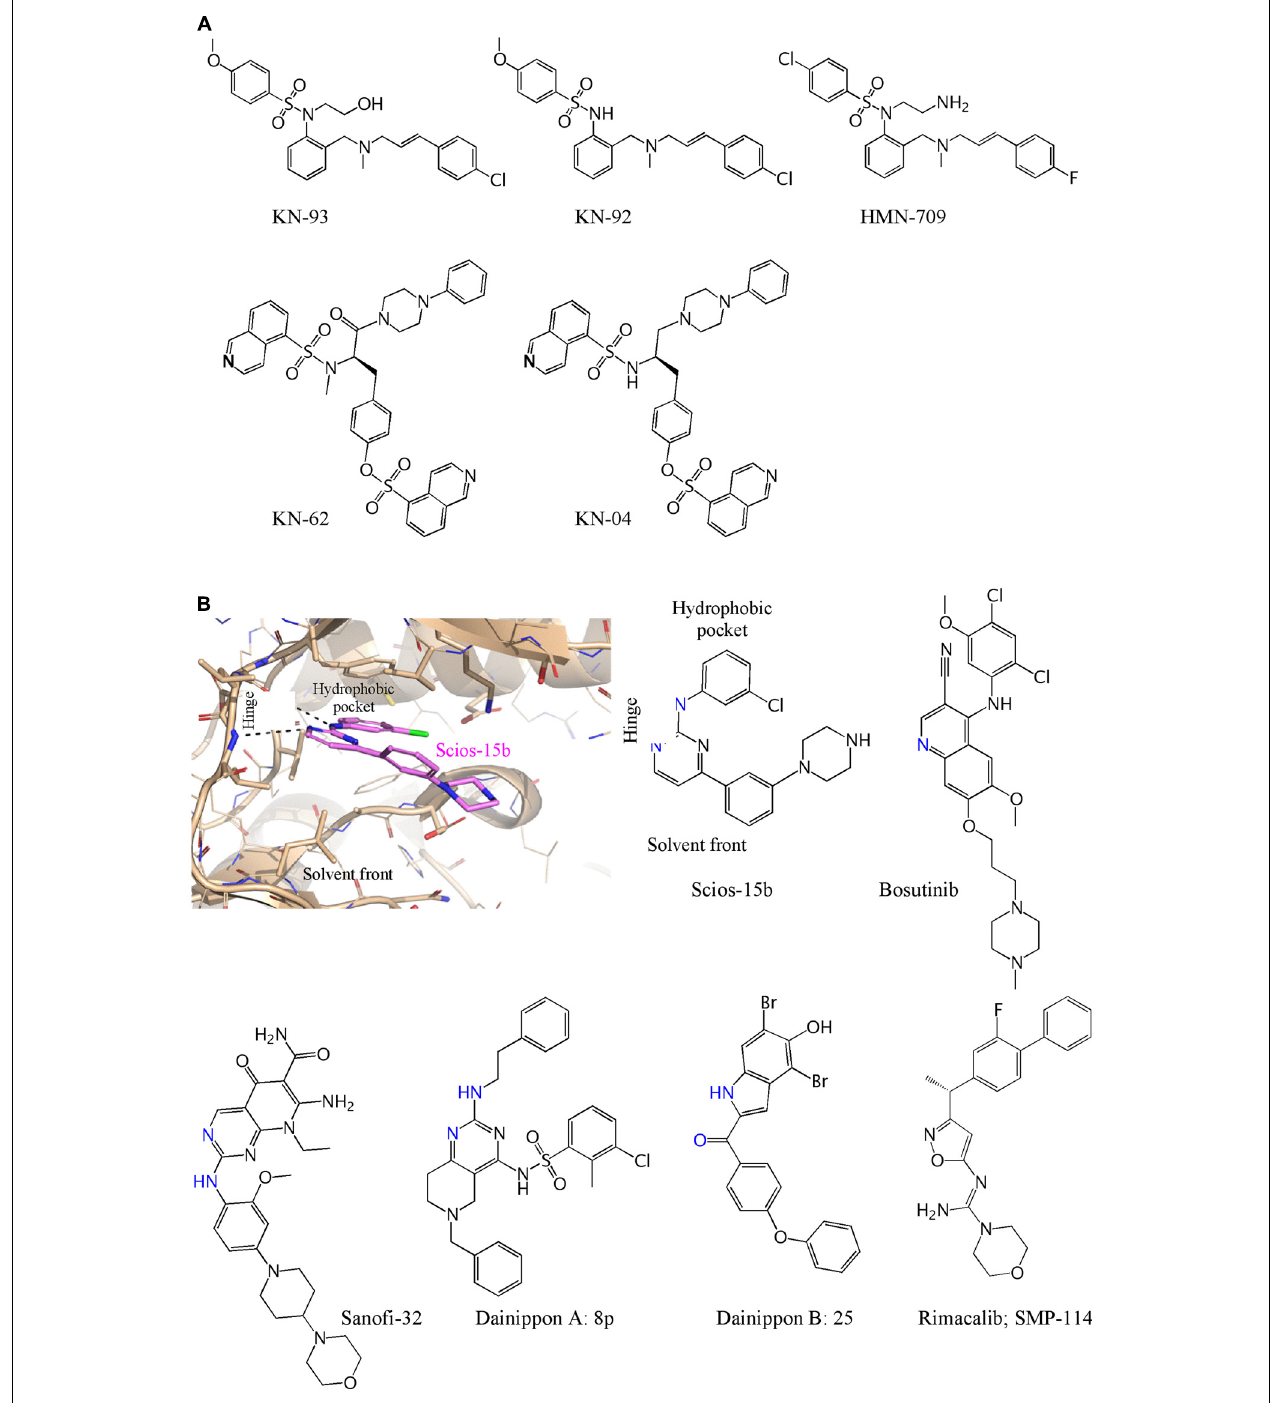
structure of Compound 15b is shown, with the same orientation, with residues that interact at the hinge in blue based on either a crystal structures (Bosutinib) or based on modeling when a reasonable docked structure could be obtained. The compounds above are: Scios-15b (Mavunkel etal., 2008); Bosutinib (Chao etal., 2011); Sanofi-32 (Beauverger etal., 2012); Dainippon A: 8p (Asano etal., 2010); Dainippon B: 25 (Komiya etal., 2012); Rimacalib/SMP-114 (Westra etal., 2010).